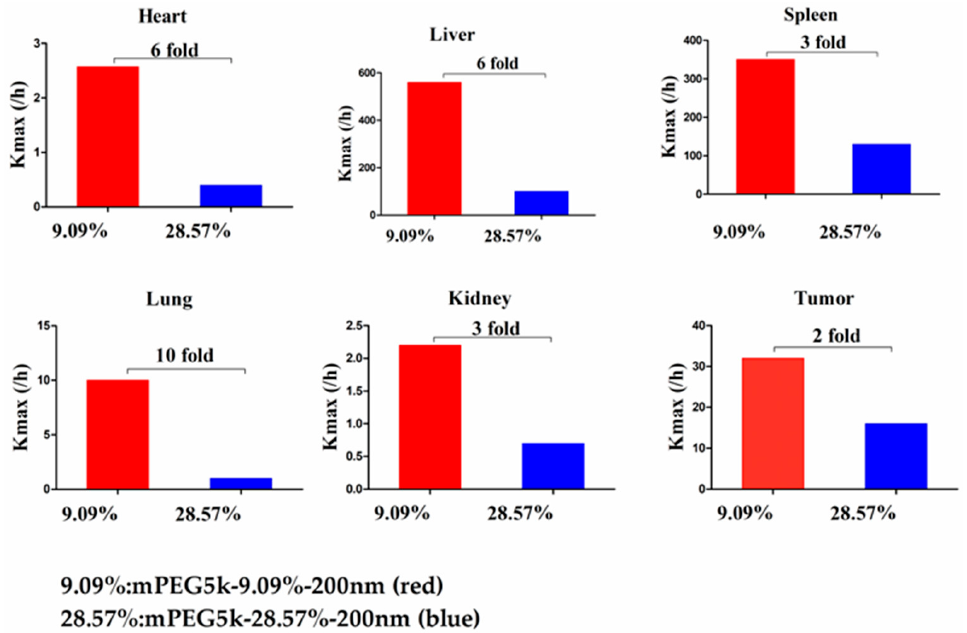
Figure 15. K max (/h) for mPEG5k-9.09%-200 nm (red) and mPEG5k-28.57%-200 nm NPs (blue).